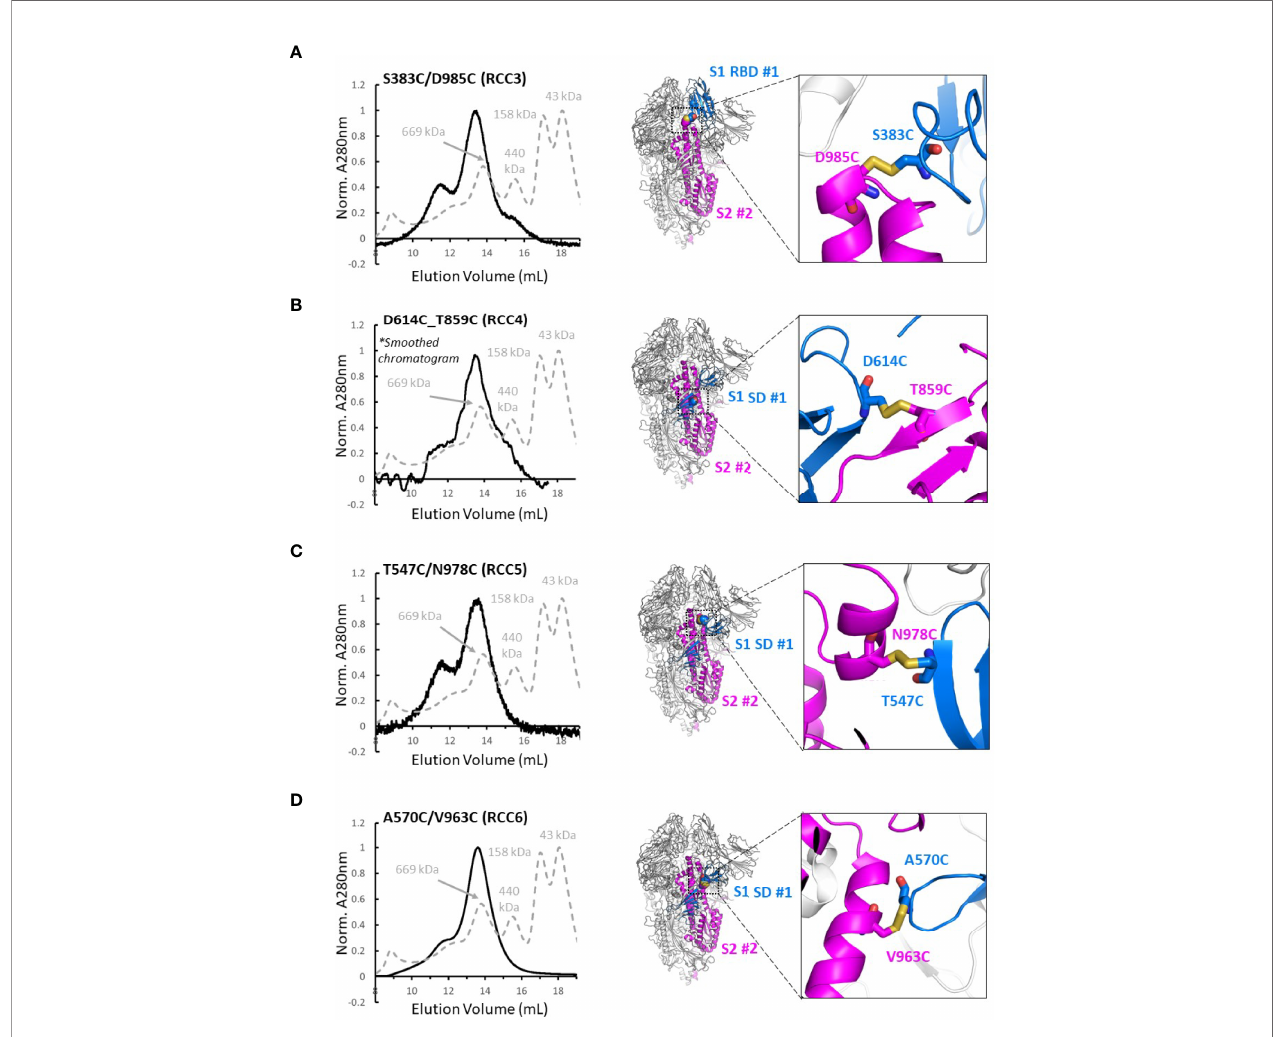
FIGURE 3 | Trimer formation of rationally designed disul fi des. SEC chromatograms (left) and corresponding structural models (right, with zoom-in) of each of the top four disul fi de designs. RCC3 (A) , RCC4 (B) , RCC5 (C) , and RCC6 (D) each migrate on the SEC primarily as a trimer with a peak corresponding to a 669kDa MW standard (Standard elution traces shown in grey). Residues that form the engineered disul fi de are shown as spheres the overall view of each model, and as sticks in each zoomed-in